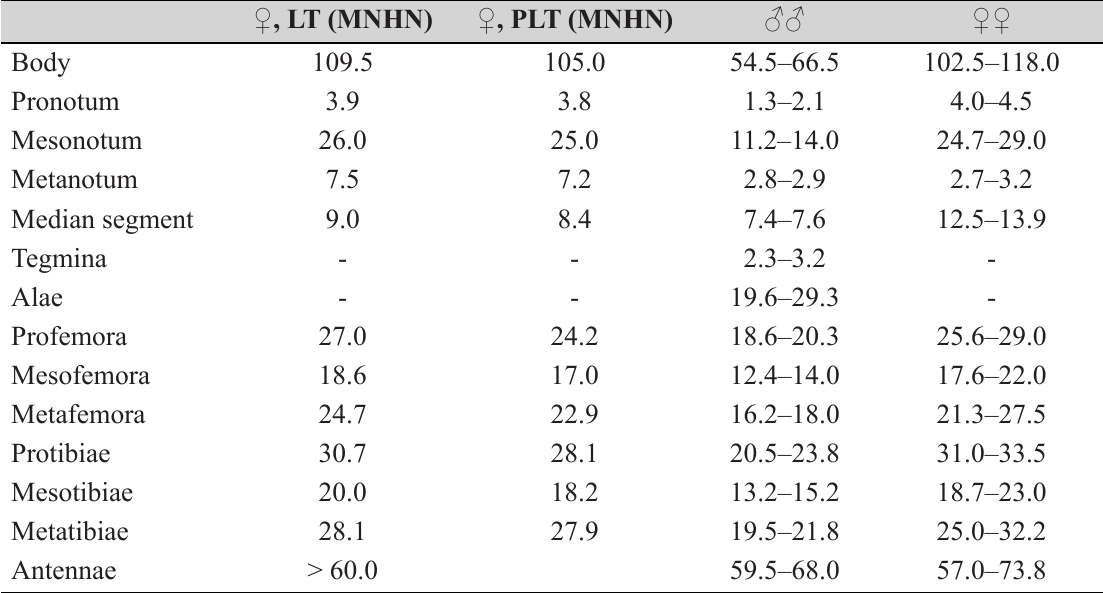
Table 11. Measurements of Phantasca quadrilobata (Chopard, 1911) comb. nov. (in mm). LT = Lectotype; PLT =